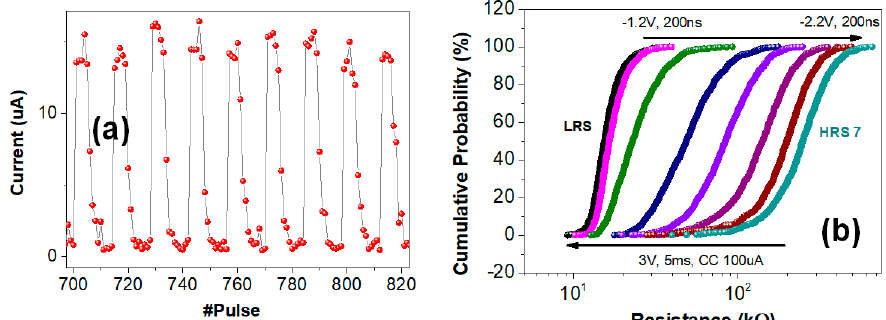
Figure 14. ( a ) Closer look at the current jumps during the endurance test from the 700th to 820th pulse cycle. ( b ) Cumulative probability of the resistance states (1 LRS and 7 HRS states) achieved by successively increasing RESET voltage pulse amplitudes ( − 1.2 V to − 2.2 V) during the multi-step RESET process, based on the pulsing scheme shown in the inset of Figure 13b